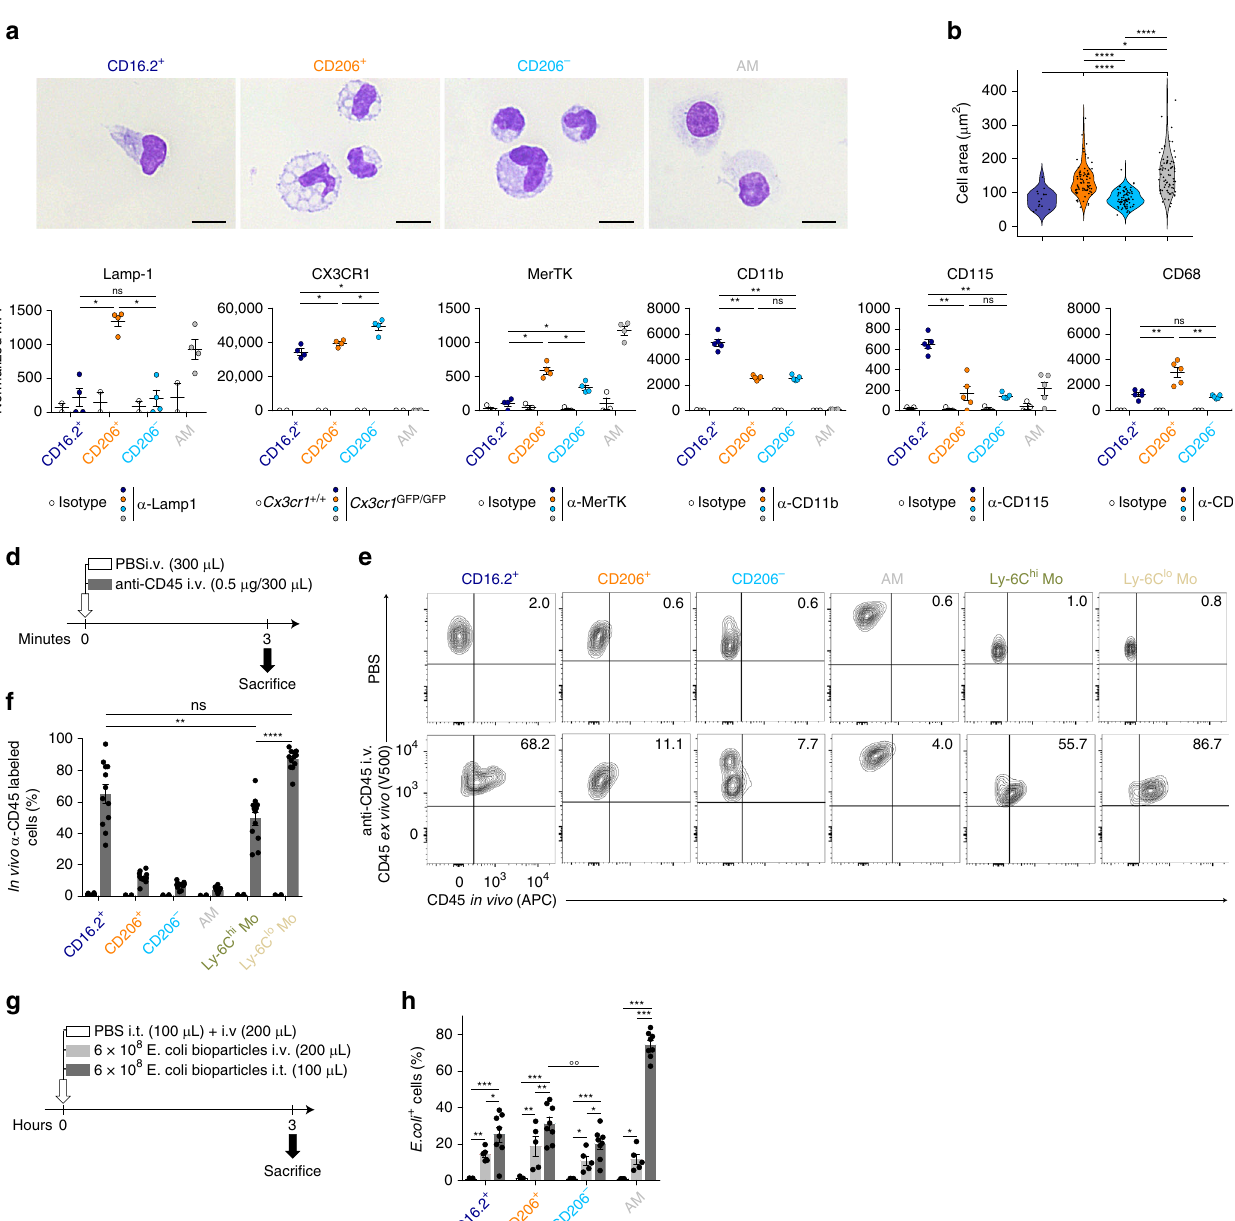
Fig. 2 Morphology, phenotype, tissue association and phagocytic abilities of lung CD64 + subpopulations. a Representative photograph of the indicated FACS-sorted populations. b Quanti fi cation of the size of cells presented as violin plots (height: cell area; width abundance of cells) and individual dots representing single cells. c Quanti fi cation of expression of the indicated markers as compared to control cells. d Experimental outline for panels ( e , f ). e Representative contour plots showing binding of anti-CD45 in vivo vs. anti-CD45 ex vivo antibodies on the indicated cell populations. Numbers indicate the percentage of double-positive cells. f Percentage of cells positive for anti-CD45 in vivo and ex vivo stainings within the indicated populations. g Experimental outline for panel ( h ). h Percentage of E. coli bioparticle-positive cells 3 h after i.v. or i.t. administration. Data show ( b ) individual cells pooled from 3 independent sorting experiments (CD16.2 + , CD206 + , CD206 − , AM: n = 16,77,75,72, respectively), or ( c, f, h ) mean ± s.e.m., as well as individual mice ( c , n = 4-5; f , n = 12; h , n = 5 – 8/group), and are pooled from 2 independent experiments. P- values were calculated using ( c , f ) non-parametric Mann – Whitney tests for pairwise comparisons or ( h ) a linear mixed model on log(y + 1)-transformed values with Tukey ’ s post hoc test. * P < 0.05; **/°° P < 10 − 2 ; *** P < 10 − 3 ; **** P < 10 − 4 ; ns, not signi fi cant. Empty circles compare % of E. coli + cells after i.t. injection in CD206 + vs. CD206 − IM subsets. Source data are provided as a Source Data fi le. i.t., intratracheal; i.v., intravenous; MFI, Mean Fluorescence Intensity. Scale bar = 10 µ